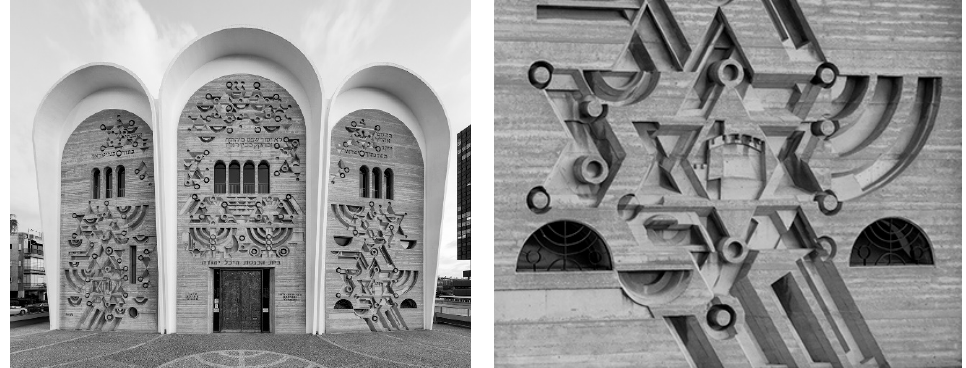
Figure 12. Heichal Yehuda Synagogue, Tel Aviv. Left : Yehezkel Kimchi, concrete relief on the synagogue’s façade; right : detail, Thessaloniki’s White Tower. Photos: Eli Singalovski, 2018. Used with permission .